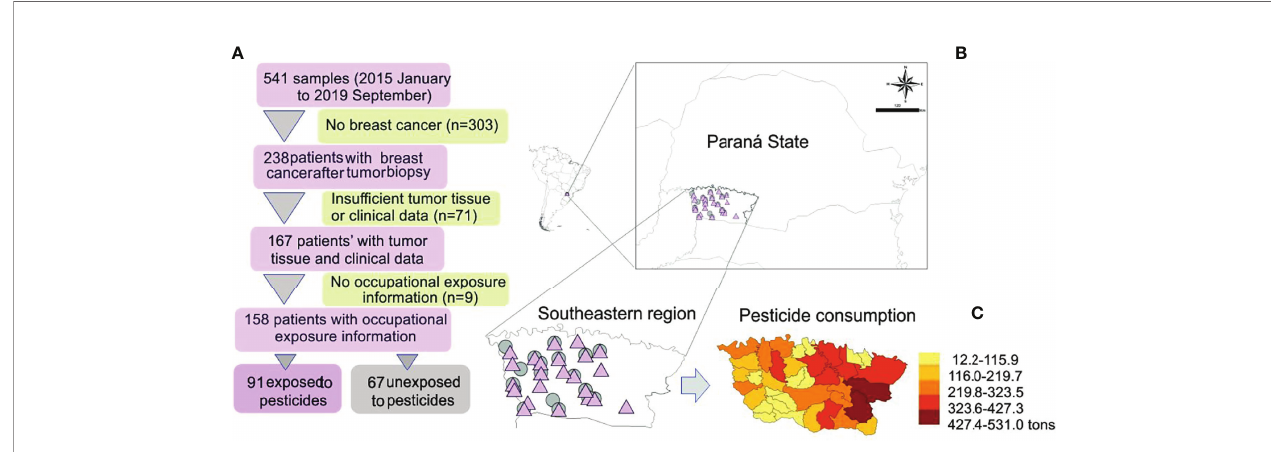
FIGURE 1 | (A) Study design and map showing the sample distribution according to exposure. (B) Ampli fi ed map of Brazilian Parana ́ State with symbols representing exposed (pink triangle) and unexposed (gray circle) patients ’ localities. (C) Detail of pesticide consumption in the study area; modi fi ed from Gaboardi et al.